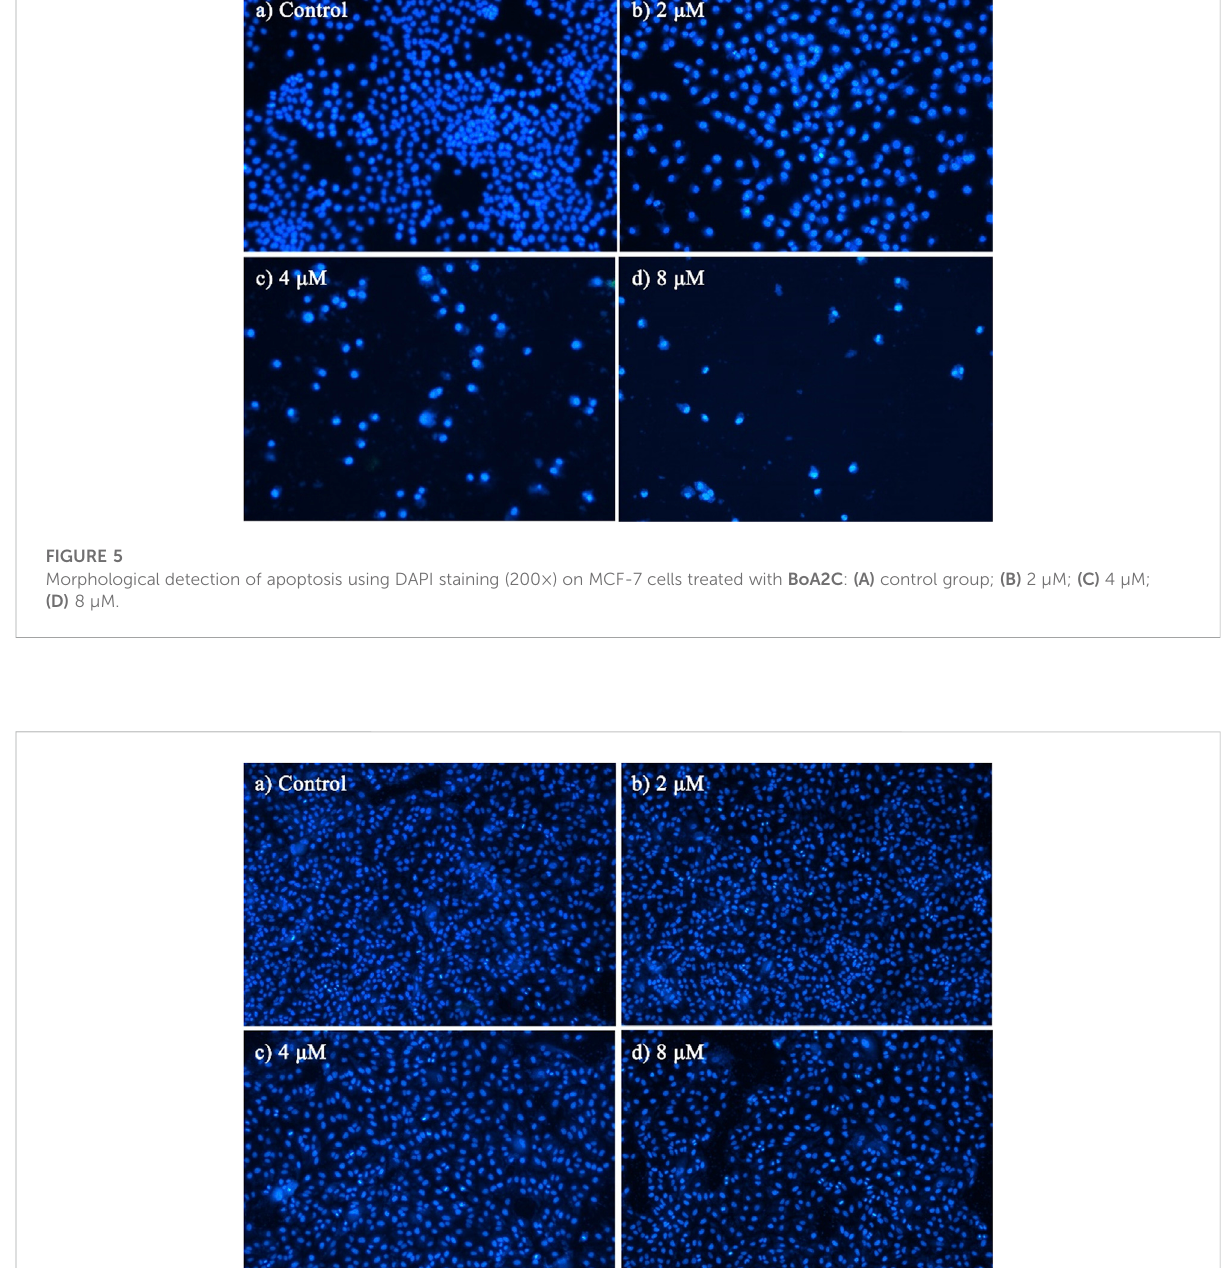
stable operation, all combined QC samples for running all QC